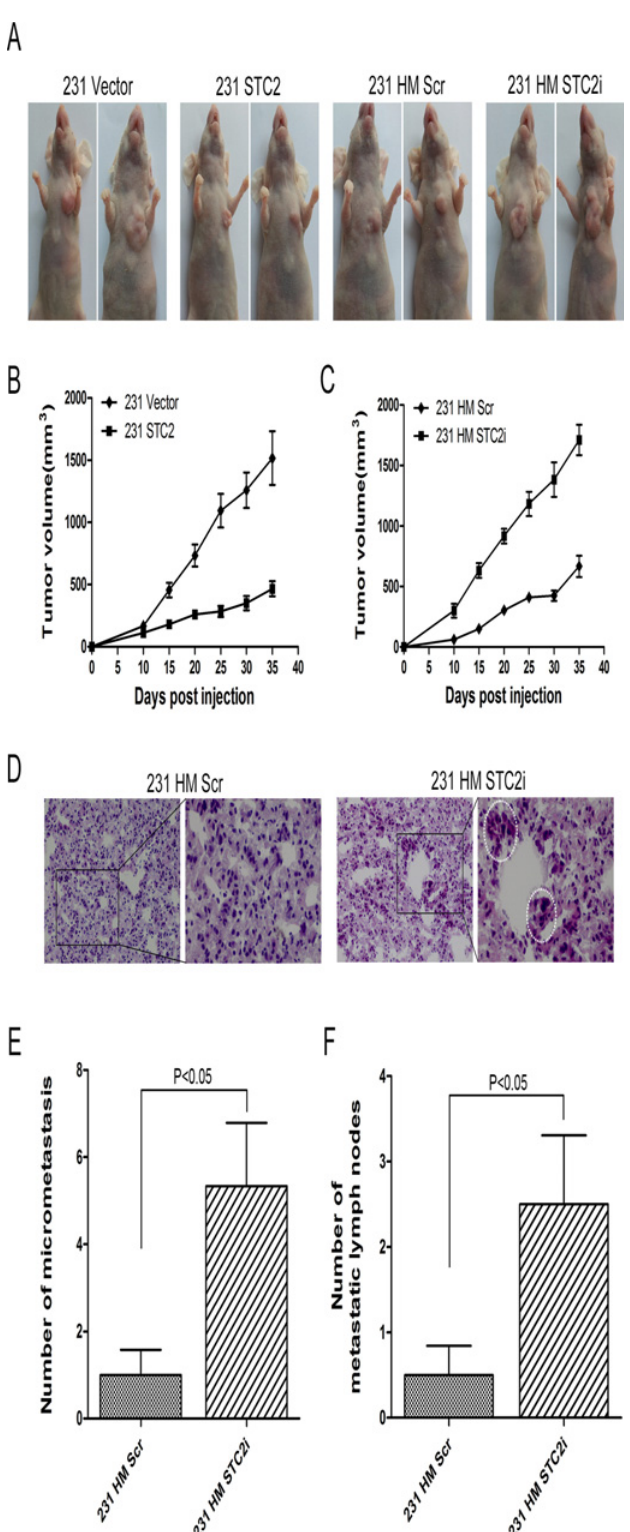
Fig 6. Knockdown of STC2 enhances tumorigenicity and metastasis. A , In vivo tumor growth examined by animal assay. B-C , Fat pad tumor growth from mice injected with 231 STC2 cells and 231 HM STC2i